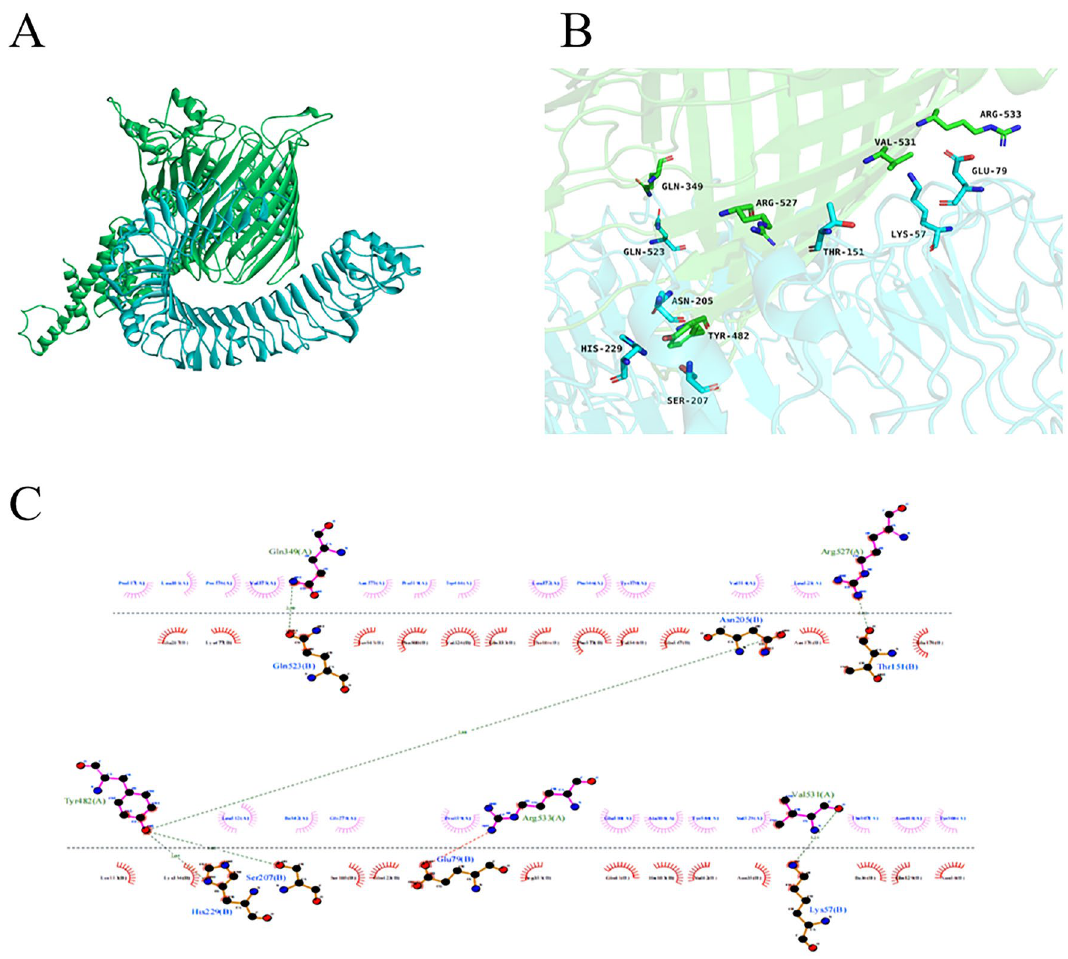
Figure 9. ( A ) Docked complex of vaccine constructs with TLR4; vaccine constructs in green color and TLR4 receptor in blue color. ( B ) The MEV-TLR4 complex was analyzed for interactions and their 3D images were taken by using visualizing tool PyMol. ( C ) The MEV-TLR4 complex was analyzed for interactions and their 2D images were taken by using visualizing tool Ligplot.